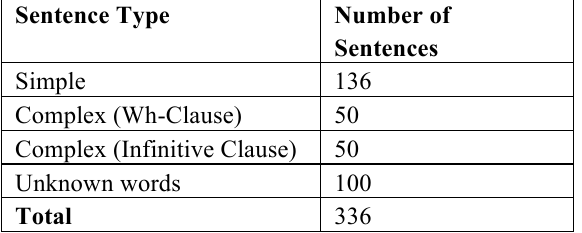
Table 6. Different category of test-set sentences